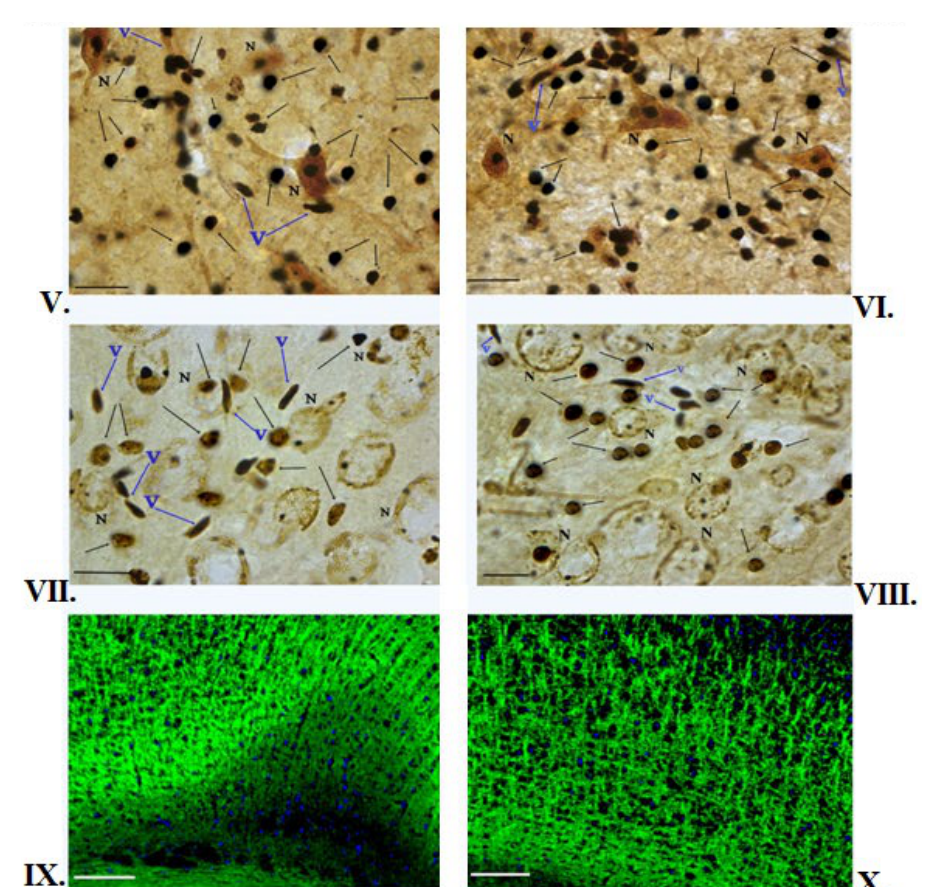
Figure 2. OLGs of the red kangaroo NC. ( I , II )—Nissl staining (scale bar 10 µm); ( III , IV )—Klüver– Barrera staining (scale bar 10 µm); ( V , VI )—Glial tissue impregnation with silver salts. Arrangement of OLGs next to each other (scale bar 20 µm); ( VII , VIII )—Histochemical method for detection of iron in OLGs (scale bar 10 µm); ( IX , X )—Immunofluorescence staining for MBP (scale bar 50 µm). Blue nuclei stained with DAPI. Notations: —male; —female; N—neuron; v—blood vessel.